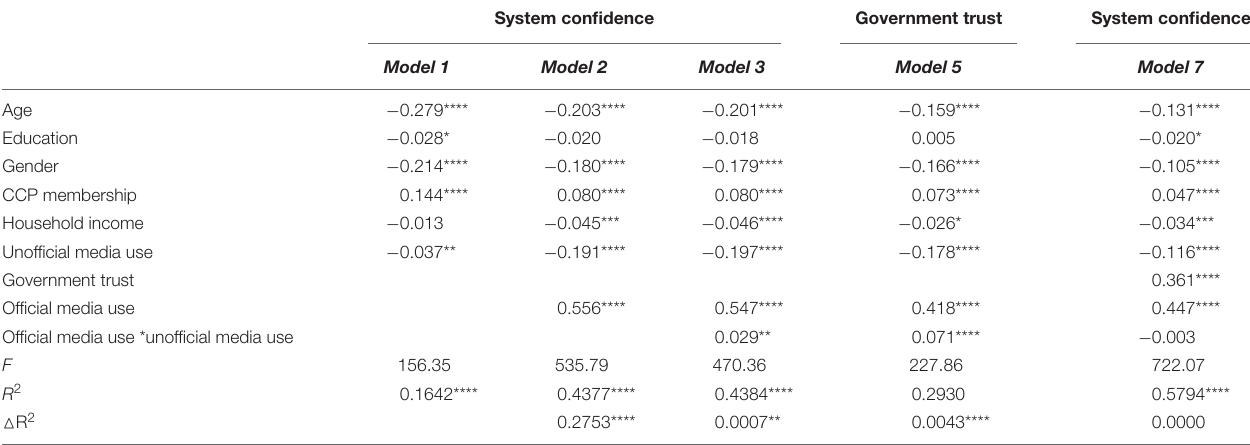
TABLE 5 | Main effect, moderating effect, and mediated moderating